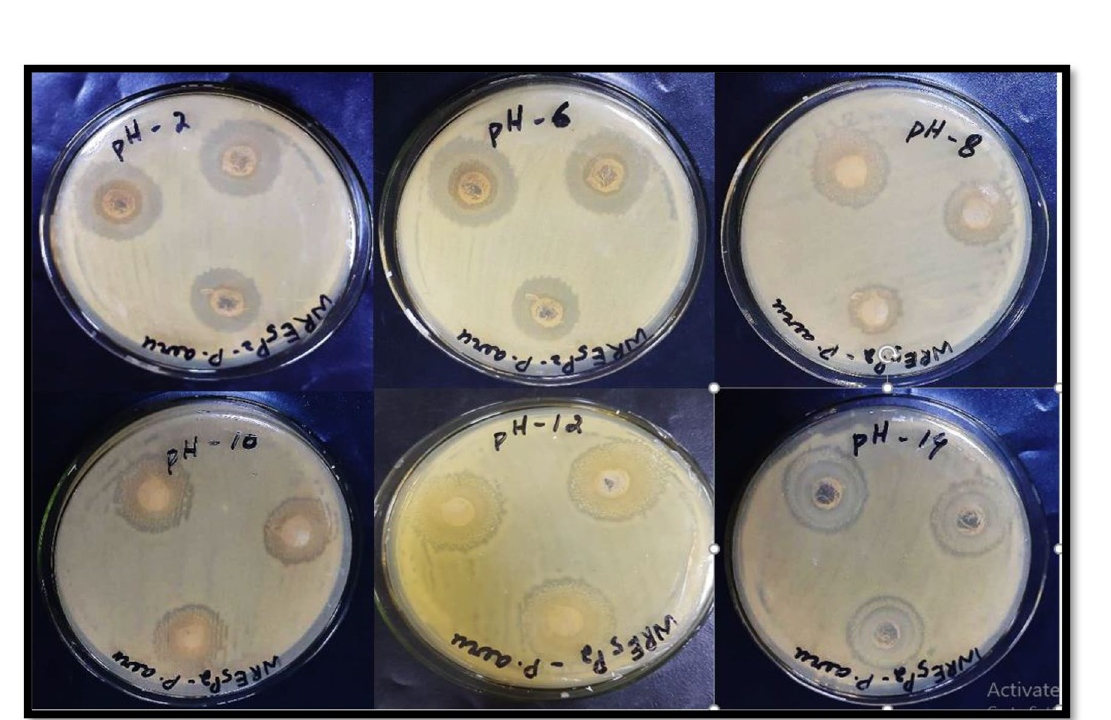
Fig. 5 Effect of different pH on bacteriocin activity against specific